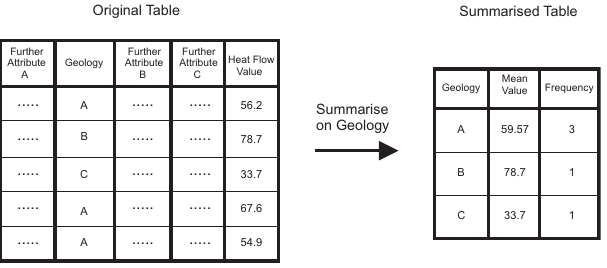
Fig. 9. Schematic illustrating the process of producing a summary table. A target field is selected, in this case geology. The process “summarises” selected fields in defined manners e.g. mean, sum, standard deviation, that correspond to each unique entry in the se- lection field. In the example illustrated, the mean heat flow has been summarised for each geology category. The summary table will also contain the number of rows (heat flow measurements) contributing to each summary